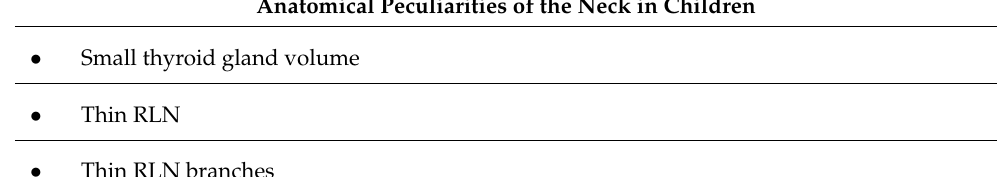
Table 1. Peculiarities of the neck in children. Knowledge about these variations is extremely im- portant in clinical aspects like intubation, laryngoscopy, radiological images, thyroidectomy, and